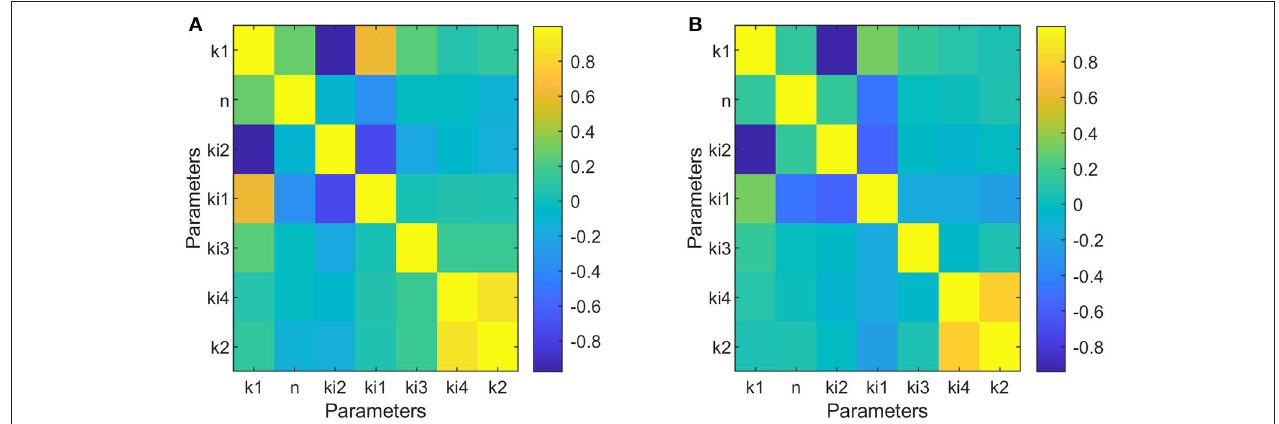
FIGURE 5 | Correlation matrices of parameters adjusted to data of dipper subjects (A) and to data of non-dipper subjects (B)